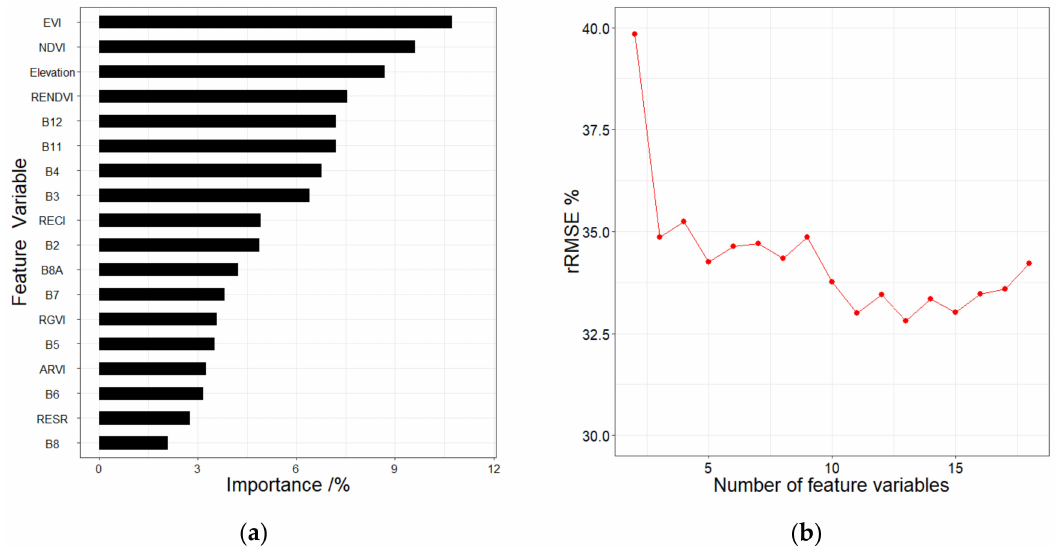
Figure 4. ( a ) The importance ranking of feature variables and ( b ) the random forest (RF) regression results (rRMSE) under di ff erent numbers of feature